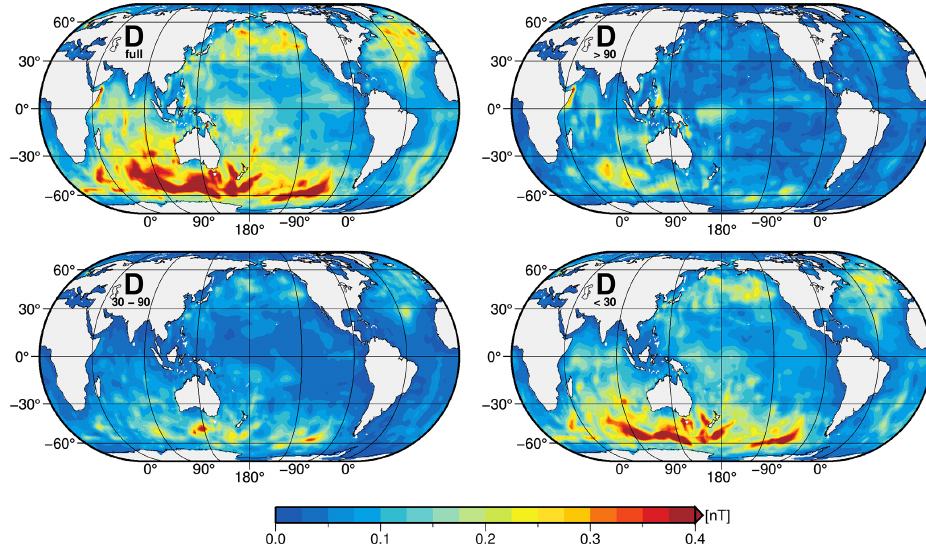
Figure 8. Frequency analysis of the ocean-induced magnetic field variability (scenario D). Upper left: all periods. Upper right: seasonal periods longer than 90 days. Lower left: medium periods between 30 and 90 days. Lower right: short periods less than 30